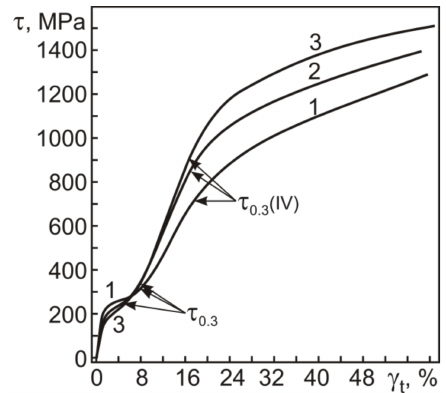
Figure 3. Engineering stress–strain diagrams in torsion at 295 K for Ti 49.8 Ni 50.2 before (1) and after warm abc pressing at 723 K with true strains e = 1.8 (2) and e = 8.4 (3).